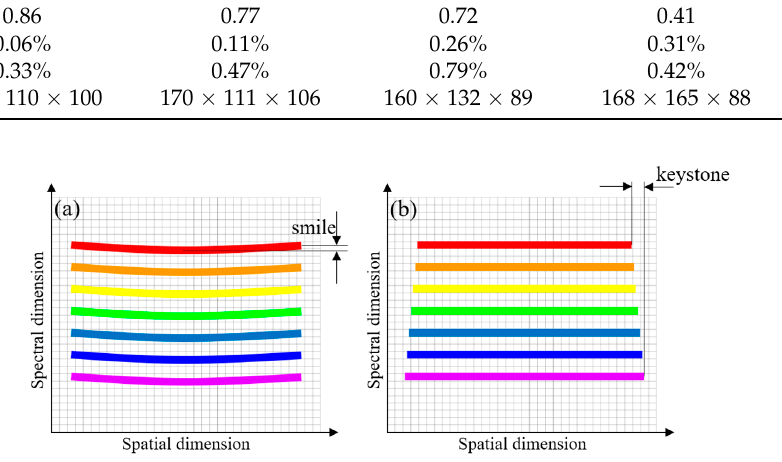
Figure 7. Spectral lines showing smile and keystone distortions. ( a ) Smile, ( b ) keystone.